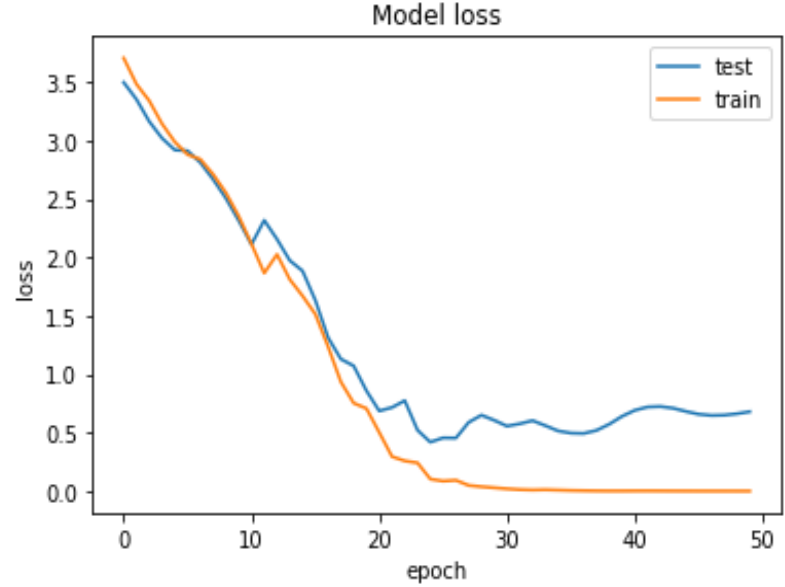
Figure 16. Proposed RFER-EADL model validation loss analysis.